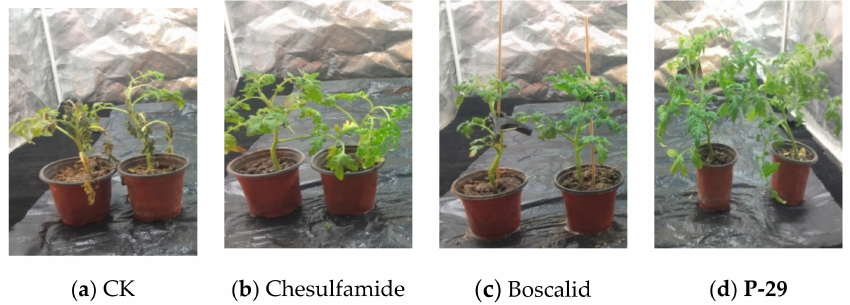
Figure 5. Tomato pot experiment.